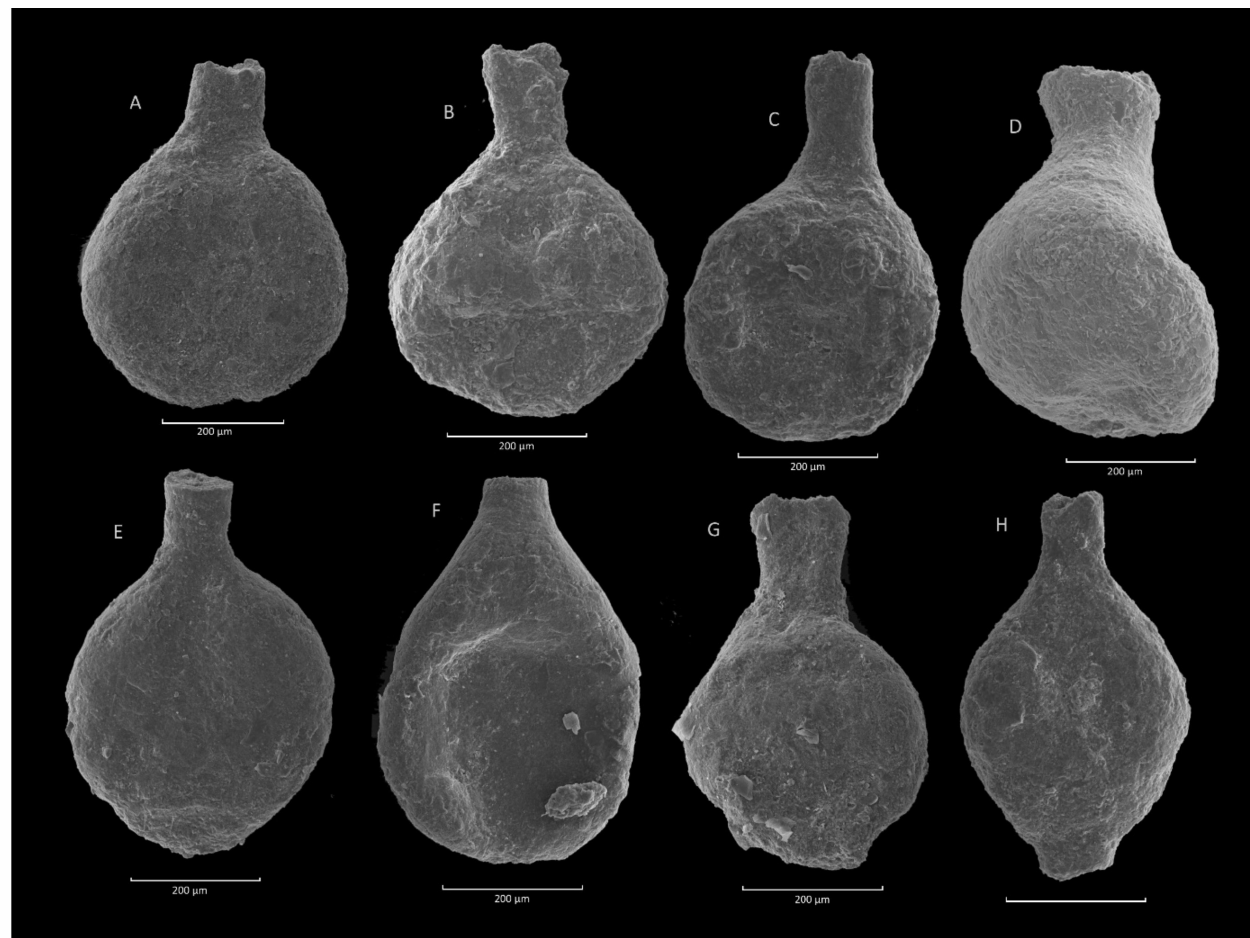
Figure 10. Caudammina ovuloides (Grzybowski). ( A – E , G ): Zimny Dział section; ( F , H ): Sucha Beskidzka